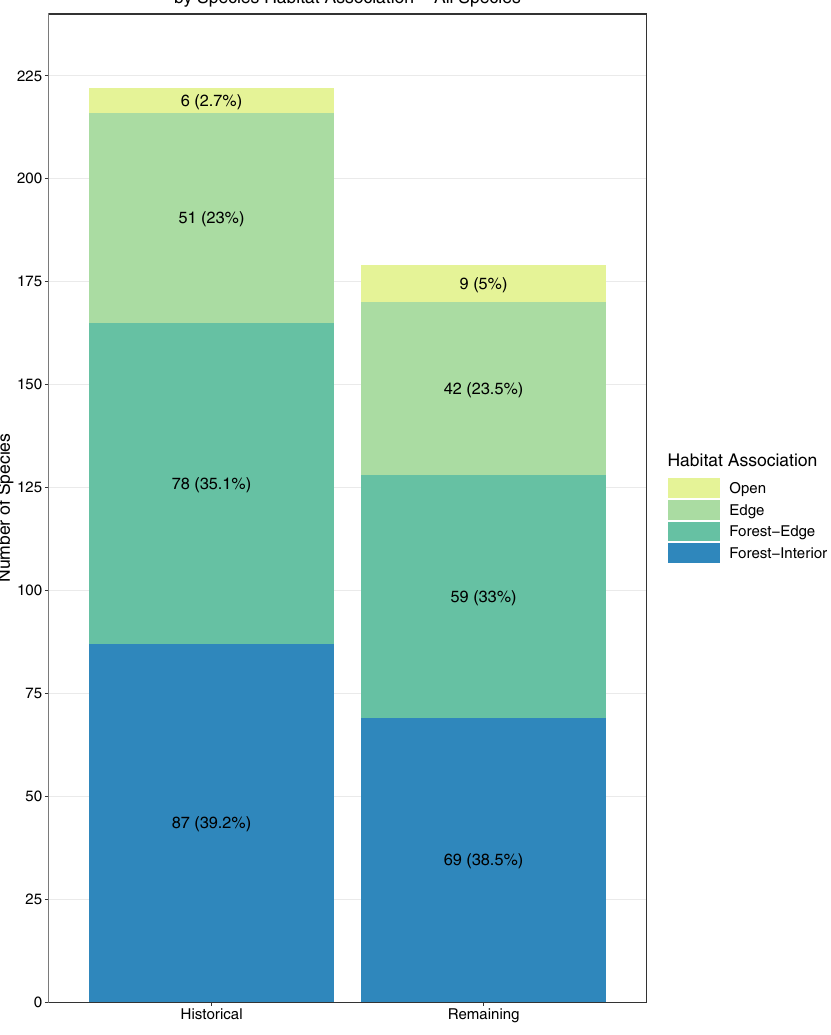
Figure 2. Change in BCI species richness over time by species habitat association, between the complete historical non-aerial, non-aquatic resident bird community and the remaining bird community today. “Historical” refers to pre-1951 bird community, including likely but undetected birds. The remaining bird community includes permanent residents and non-permanent species that intermittently breed on the island. Values in columns denote number of species in that habitat association group (with percentage out of total species richness for that period in